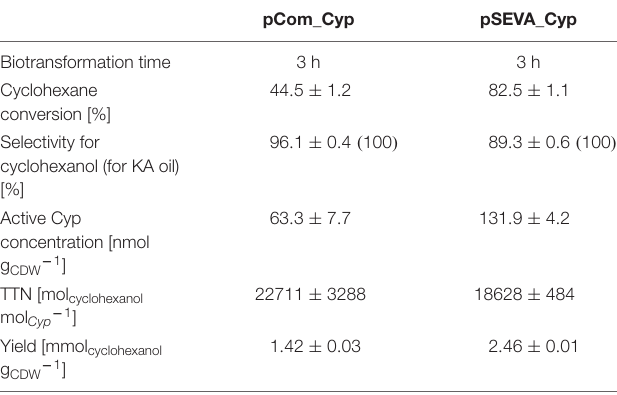
TABLE 3 | Comparison of molar conversion yield, selectivity, total turnover number (TTN), and yield on catalyst for cyclohexane hydroxylation using pCom10_Cyp and